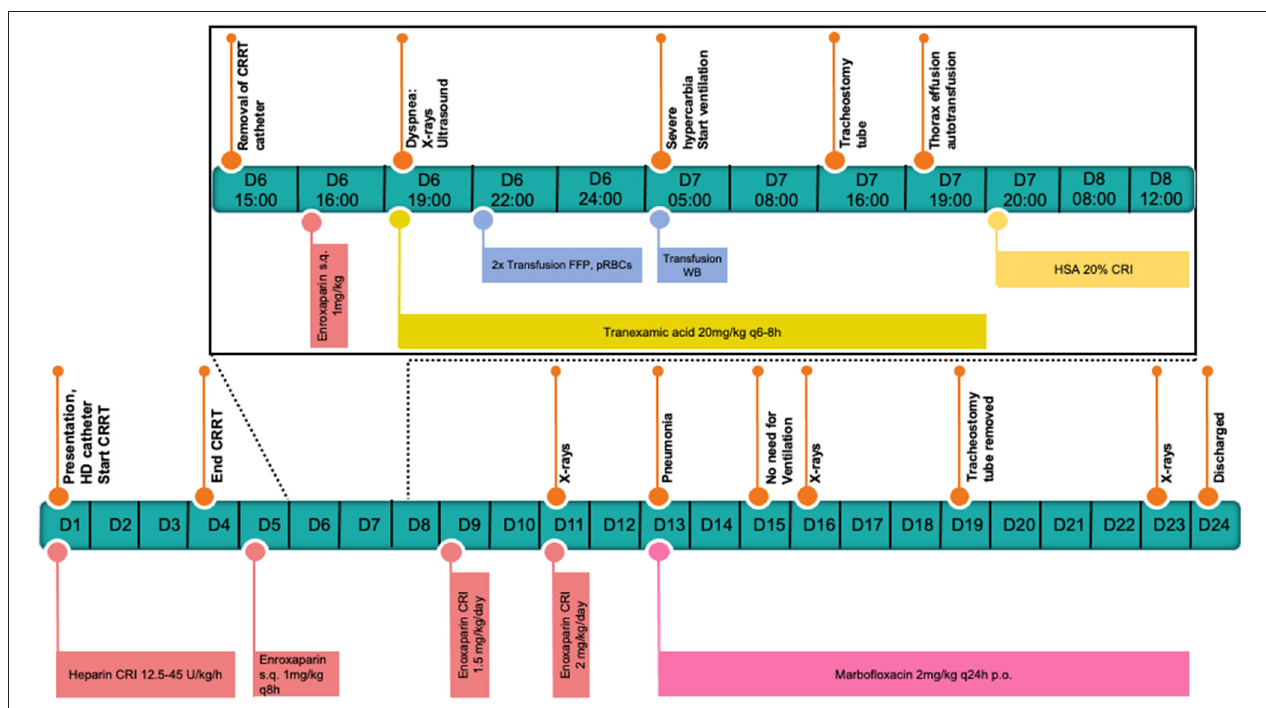
FIGURE 3 | Schematic presentation of the case management. The critical 6th day until the 8th day are presented hourly including the stabilization measurements.